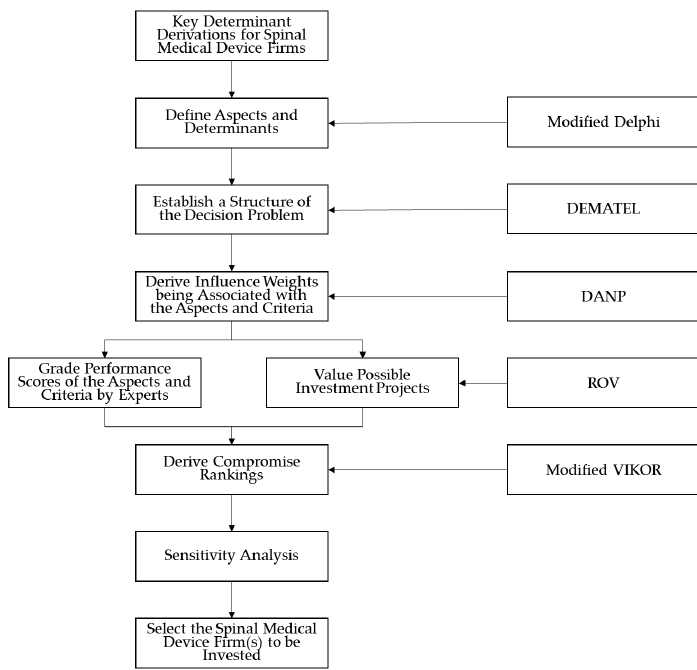
Figure 1. The flowchart of decision-making framework. DEMATEL—Decision-Making Trial and Evaluation Laboratory; DANP—DEMATEL based analytic network process; ROV—Real Option Valuation; VIKOR—VIšekriterijumsko KOmpromisno Rangiranje.